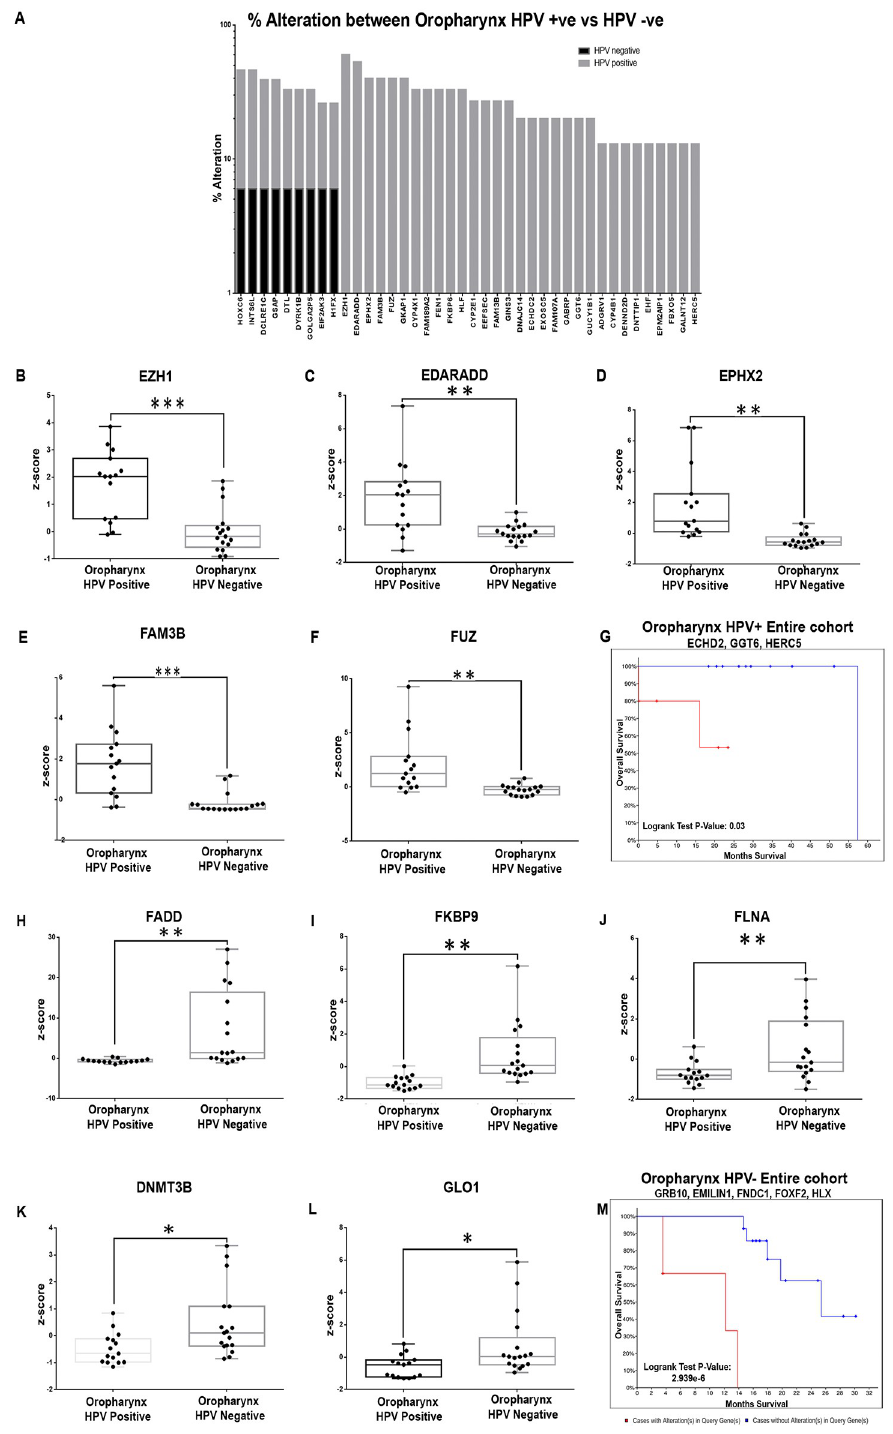
Fig 7. Marker profile of HPV+/HPV- oropharyngeal cancers in terms of percentage alterations, differential expression and survival. The significant gene entities identified from the meta-analysis of oropharyngeal cancers were compared with the oropharyngeal HPV positive and negative cohort from TCGA. A total of 31 genes showed to be highly altered in HPV positive cohort with minimal/ no alteration in negative cohort. The top 5 genes altered exclusively in HPV+ cohort included EZH1 (60%), EDARADD (42%), EPHX2 (42%), FAM3B (42%) and FUZ (35%) ( A ). Differential profiling of these genes based on mRNA expression levels (z-score) indicated that these genes